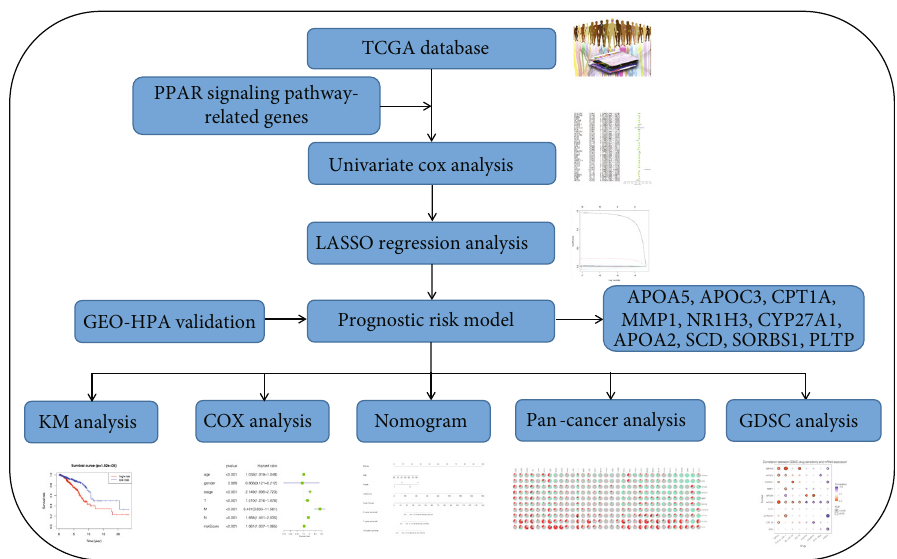
Figure 1: The fl ow chart of this